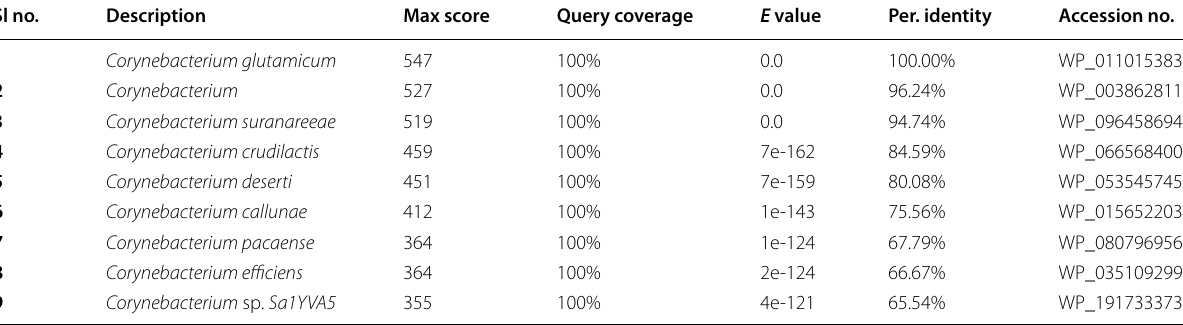
Table 1 The list of protein sequences selected for MSA Sl